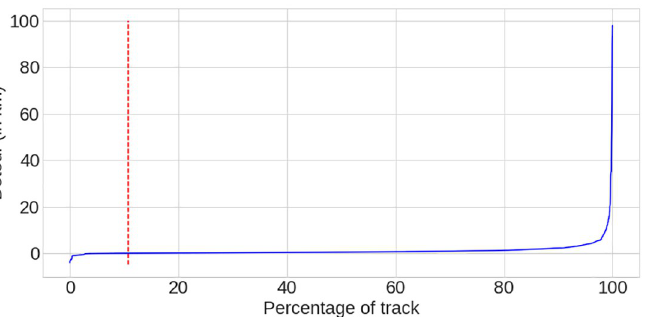
Fig 2. Distribution of distance differences between the experienced tracks and the generated shortest paths